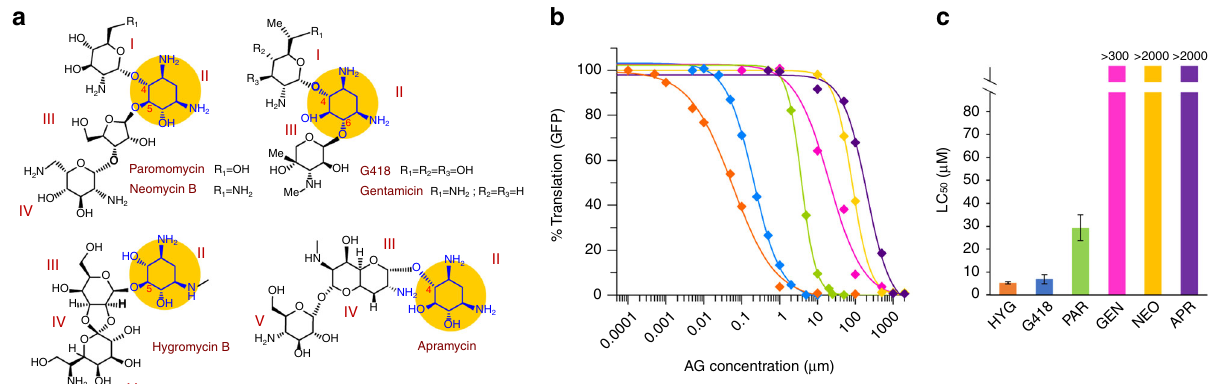
Fig. 1 Aminoglycoside effects on Leishmania and the leishmanial translation machinery. a Chemical structures of AGs used in the study. Ring numbers are indicated in red; the common 2-deoxystreptamine ring (ring II) is highlighted in yellow and the substitution patterns in derivatized compounds are given as R 1 and R 2 . b In vitro inhibition of cytosolic ribosome translation in L. tarentolae lysates. Each value represents the mean ± standard error of at least three independent experiments performed in duplicates. Hygromycin B (HYG, orange), Geneticin (G418, blue), Paromomycin (PAR, green), Gentamicin (GEN, pink), Neomycin (NEO, yellow), and Apramycin (APR, purple). c Inhibition of L. donovani promastigote growth by AGs. Values indicate drug concentrations inducing 50% inhibition of parasite growth (LC 50 ). Each value represents the mean ± standard error of at least three independent experiments